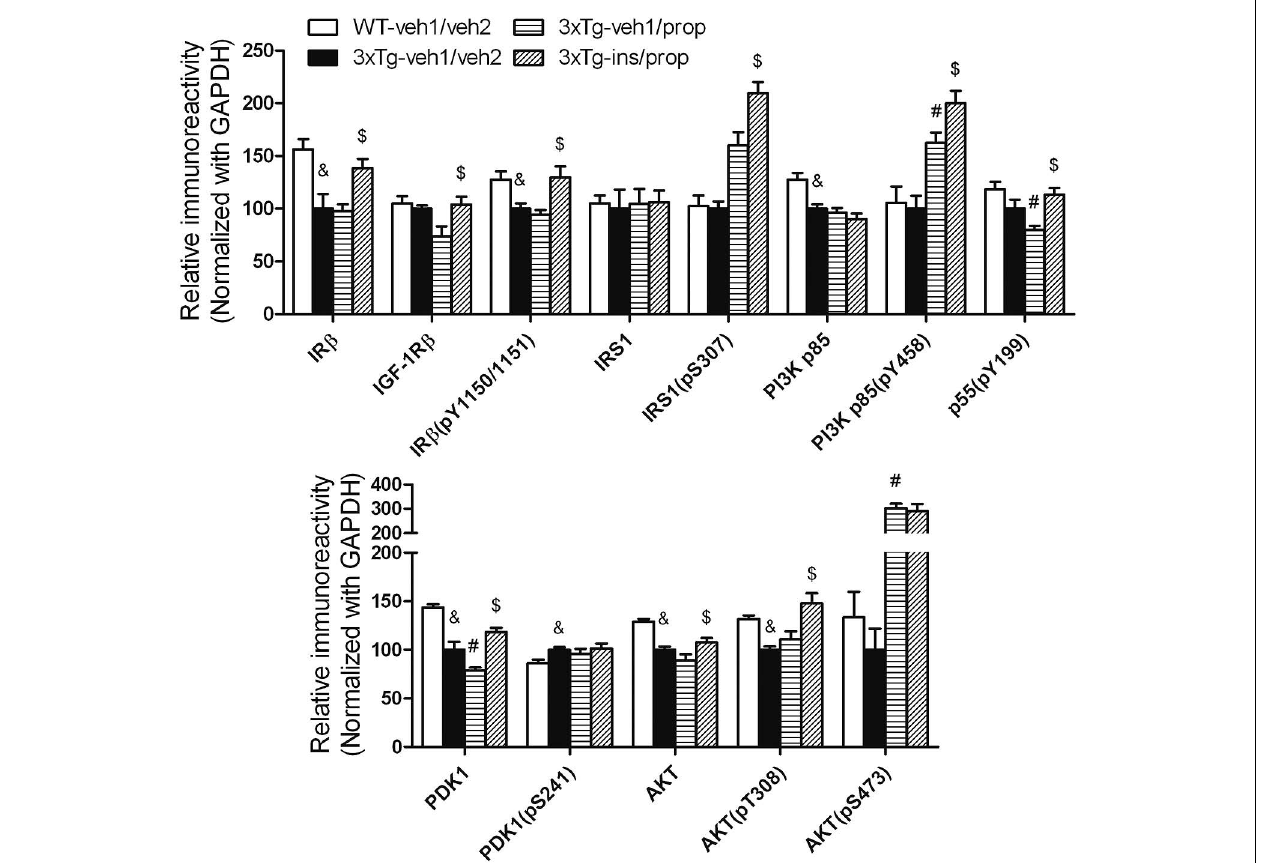
densitometrically, and the data are presented as mean ± SEM ( n = 6/group), where the values of the 3xTg-veh1/veh2 group were set as 100%. & p < 0.05